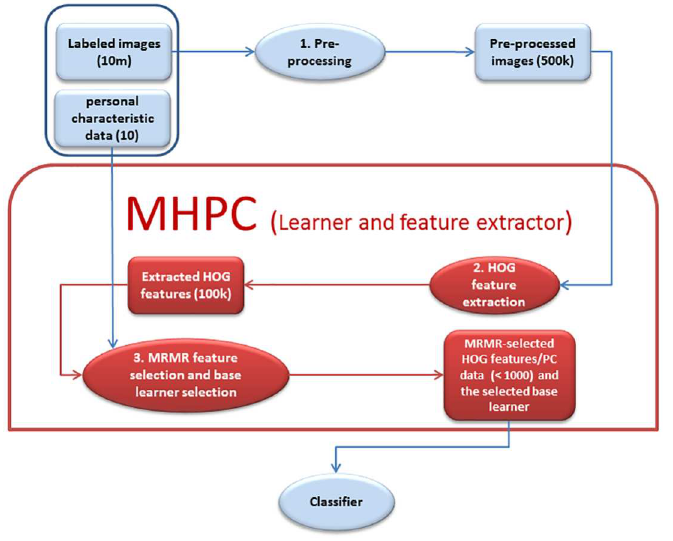
Fig 1. Summary of the learning pipeline. 1) Each image in the datasets is preprocessed (see section Preprocessing and Fig 2), reducing the dimensions from about 100,000,000(79 × 95 × 68 × 200) to about 500,000. 2) The MHPC system then extracts the 3D-HOG features of each image reducing the number of dimensions to about 100,000; see section Histogram of orientedgradients (HOG) features. 3) The last step tries to select the best learner(from the initial set of base learners) and feature set, basedon running5-fold cross validation over the trainingset, using different combinations of the numberof features and base learners. This step reduces the numberof dimensions to a numberunder 1000; see section Results. HOG feature extraction,minimum redundancymaximum relevance(MRMR) feature selectionand base learner selectionare all parts of the MHPC algorithm(shown in the red box above). See Algorithm1 for details. This figure is best viewedin